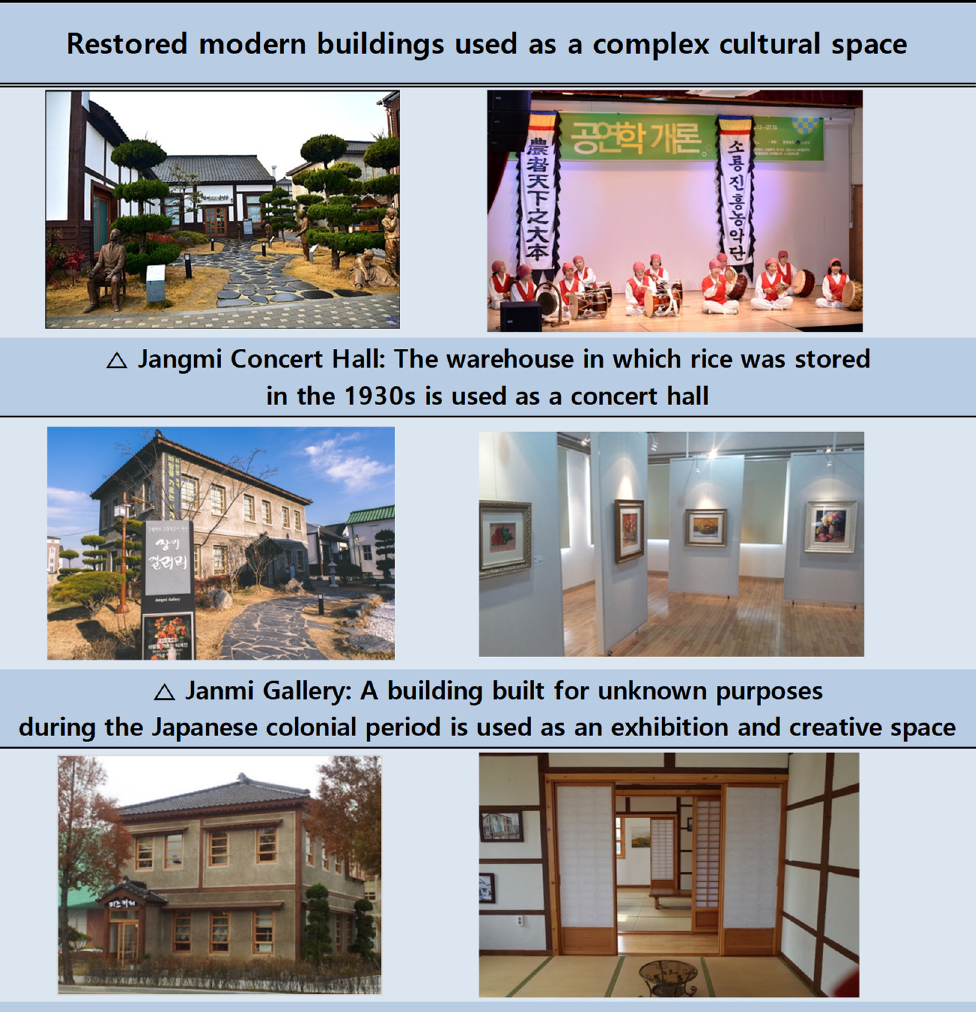
Figure 5. Site-specific resources used as complex cultural spaces in